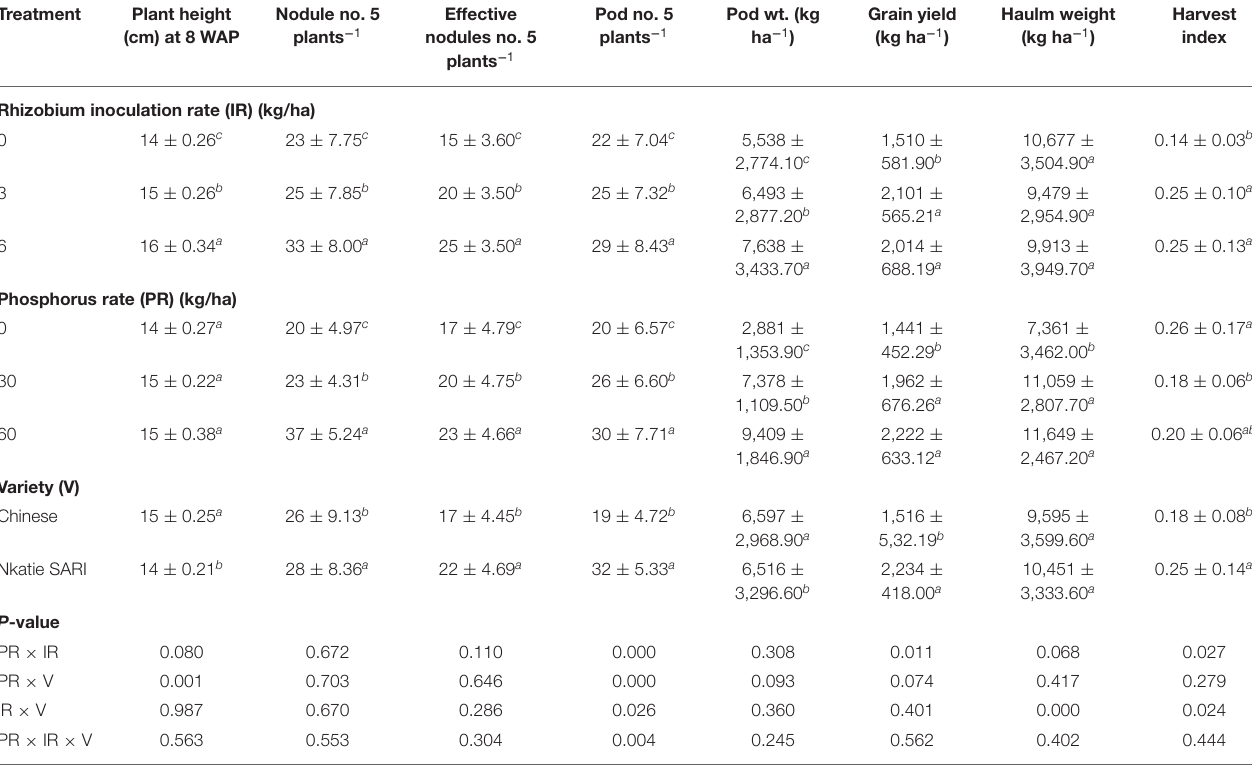
TABLE 3 | Plant height, nodulation, yield, and yield components of groundnut as affected by variety, phosphorus, and rhizobium inoculation rates in the on-station experiment. Treatment